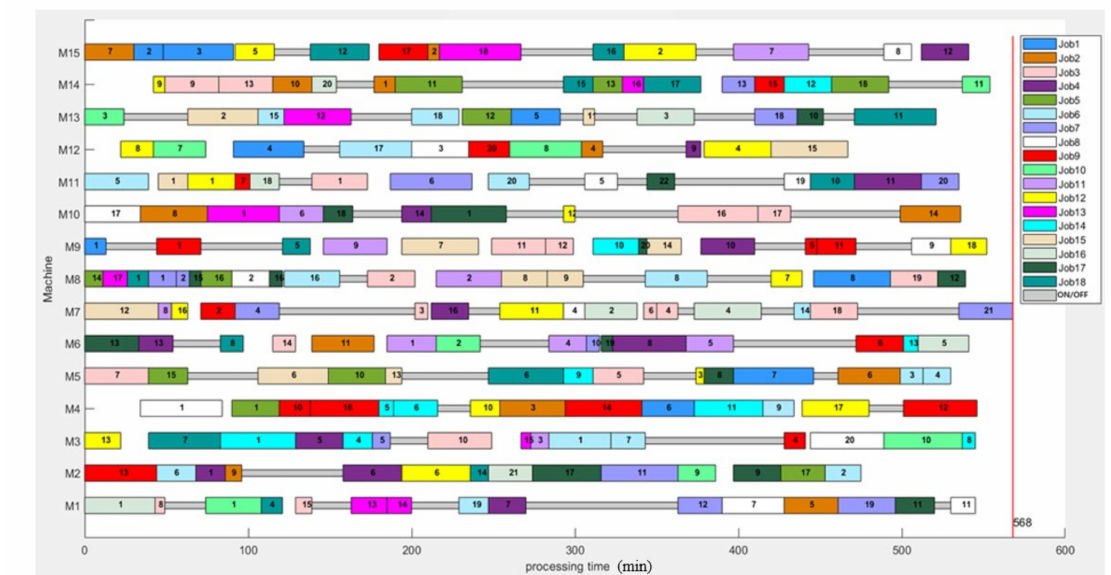
Figure 14. The Gantt chart of scheduling scheme for single-objective